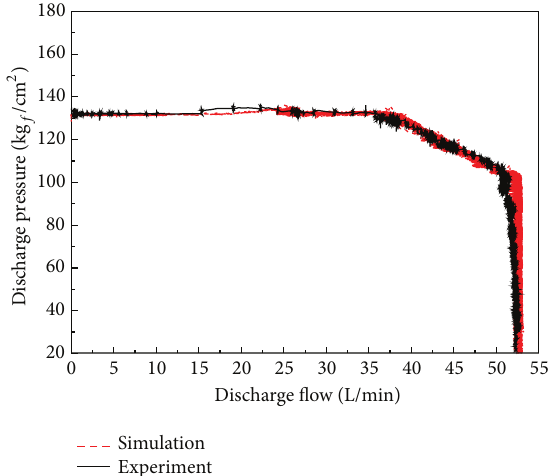
Figure 23: Output of discharge flow through simulation and experiment.